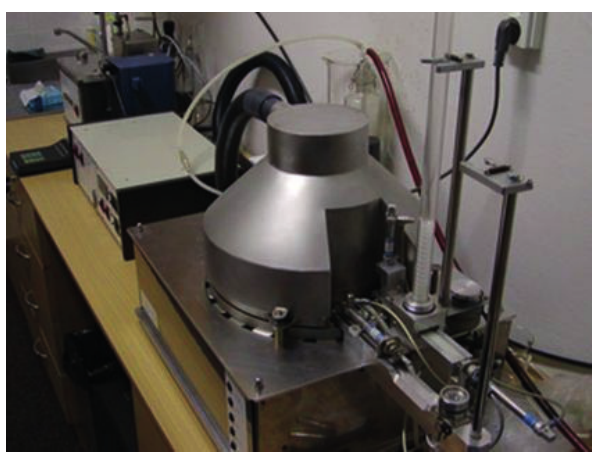
Figure 3. Lens machine for spin casting, the carousel type from the